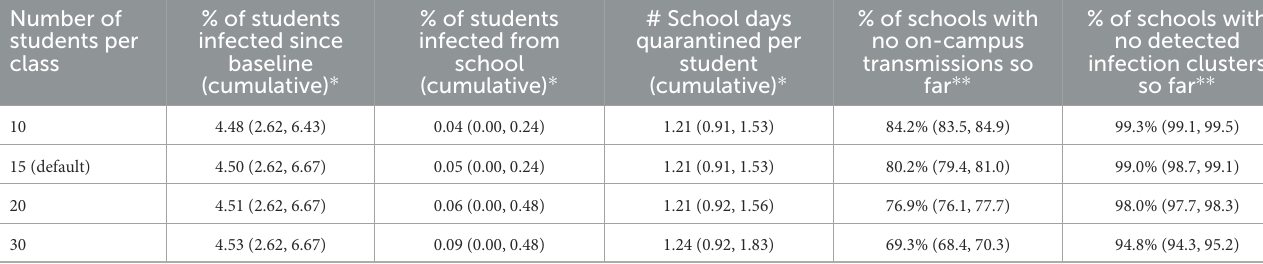
TABLE 1 Mean-average outcomes after 2 months of in-person instruction, by class size. Number of students per